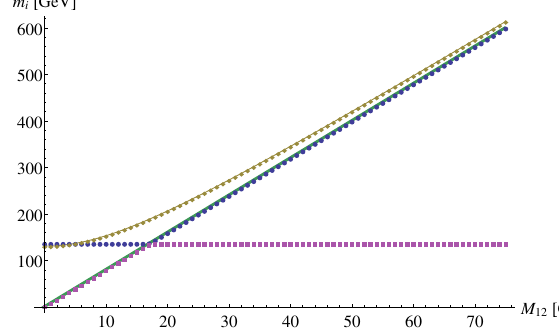
for tan β = 66. The purple boundary marks the metastability/instability (μ) is shown boundary,withtheunstablesideshaded.Thebluedashedregionisgiven 2 by the size of the contribution of the one-loop effective potential. The (μ) (blue line) black dotted line shows the naked one-loop RG running of λ 1 l 2